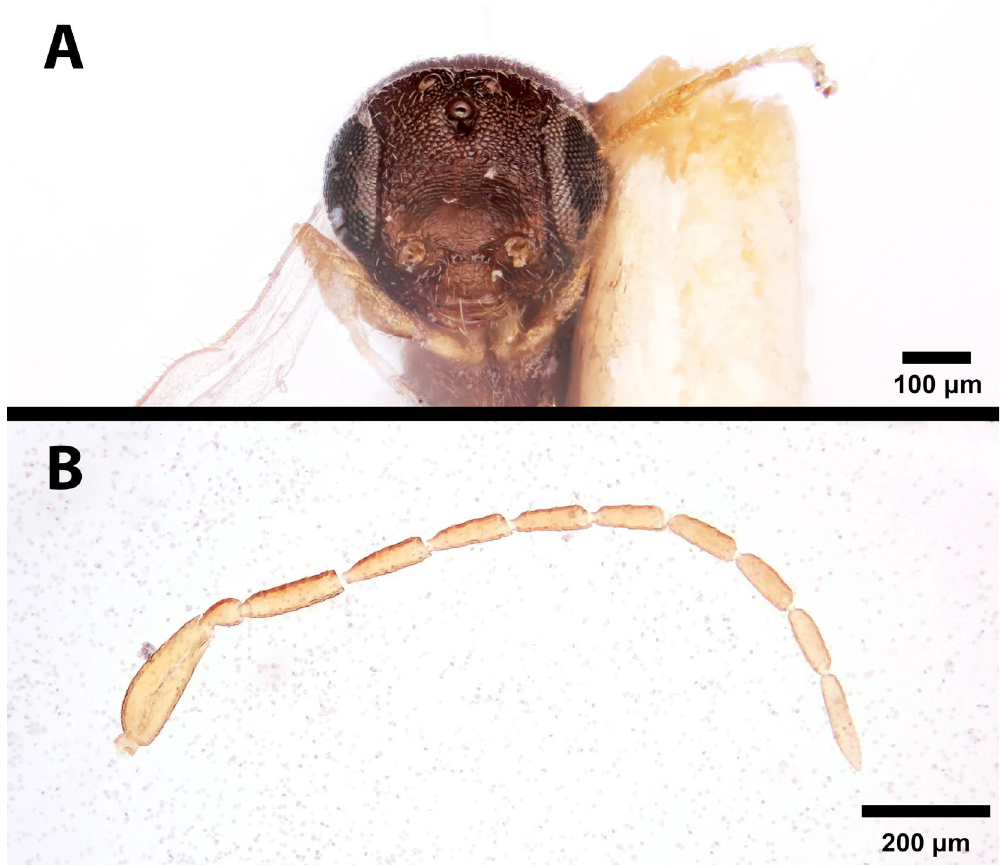
Fig. 3. Ceraphron mymecophilus kieffer, 1913, synonymized with Aphanogmus abdominalis (Thomson, 1858). Syntype, ♂. A . Frontal view (MNhN EY22475). B . right antenna (MNhN